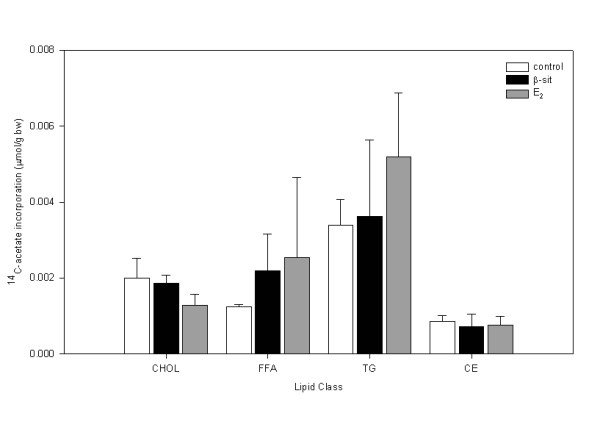
Gonad lipid 14C-acetate incorporation (μmol/g bw) towards cholesterol (chol), free fatty acid (FFA), triglyceride (TG) and cholesterol ester (CE) in female goldfish exposed to control, β-sit (200 μg/g) and E2 (10 μg/g) via Silastic® implants for 21 days. Values are presented as means ± SE. There are no treatment differences (p > 0.05).